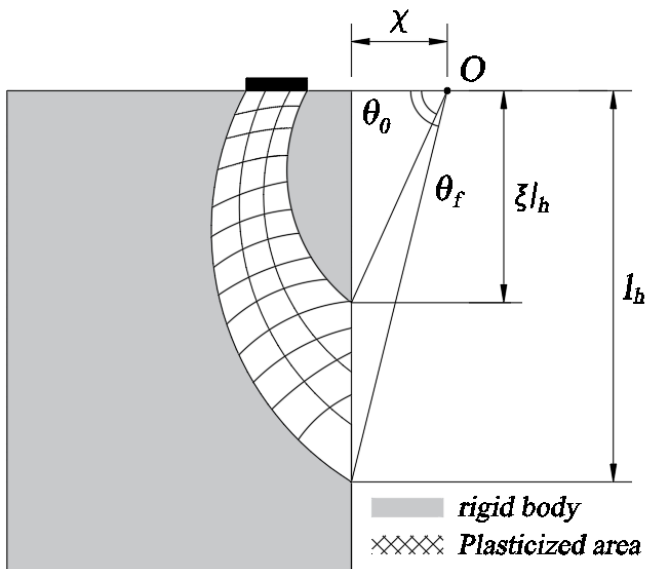
Figure 17. Spiral failure mechanism (Plumey, 2011).